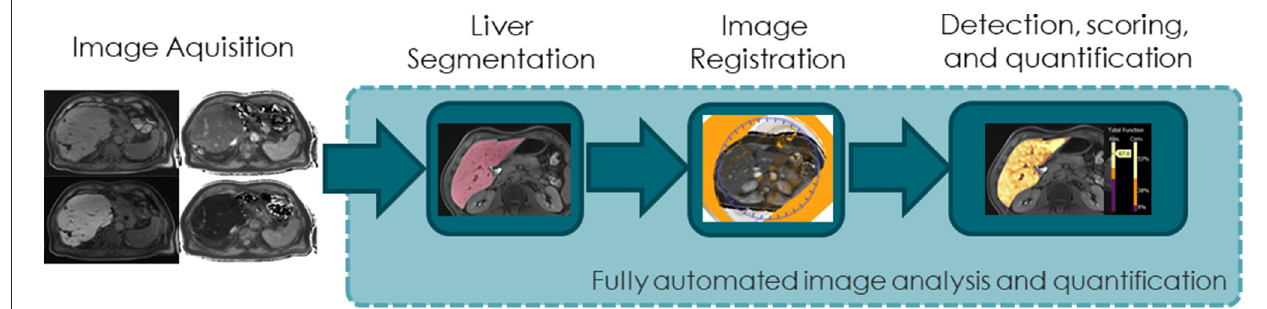
FIGURE 2 | Diagram illustrating the steps needed for automated image analysis to quantify liver function.